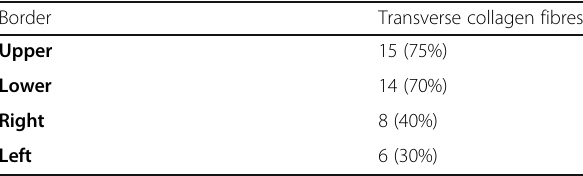
Table 1 Comparison between the four borders of the ring of the direct umbilical hernia as regard the predominance of the transverse collagen fibres (number of cases) Border Transverse collagen